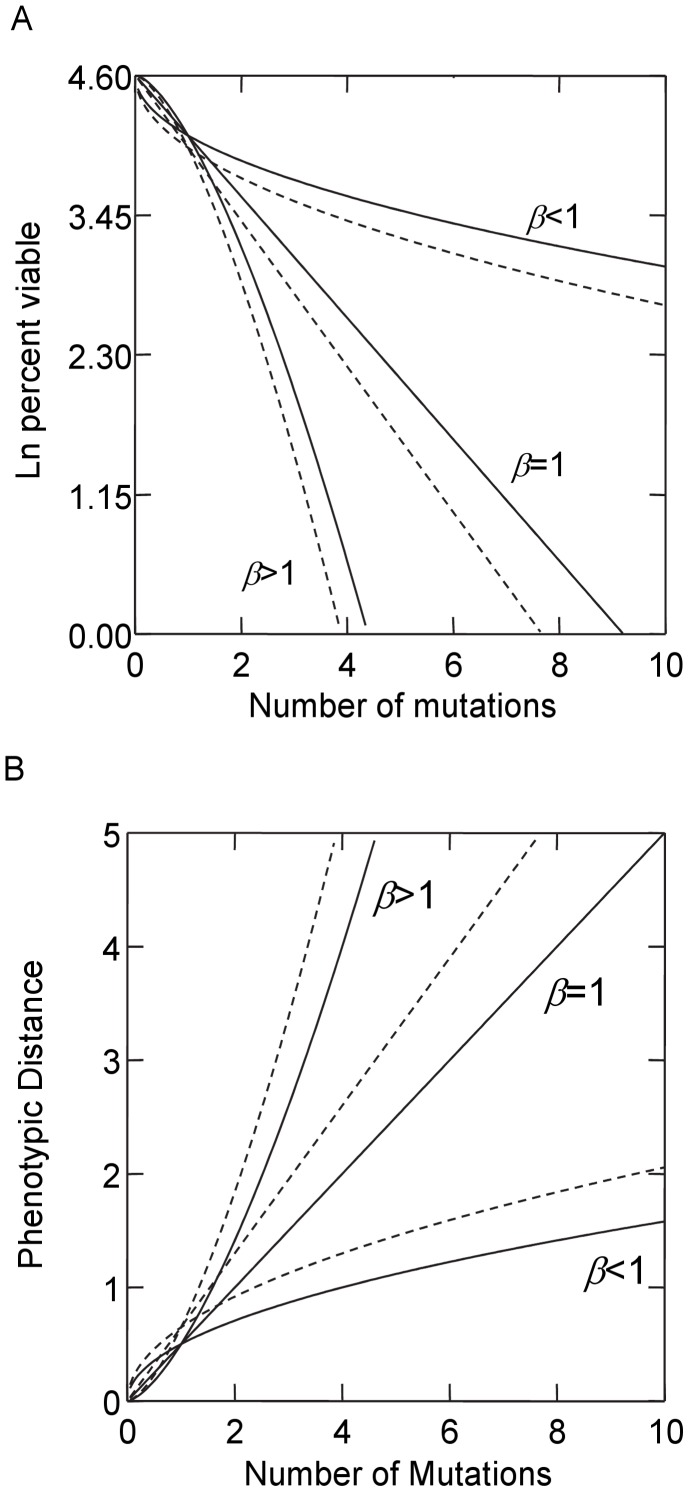
Hypothetical relationships between correlates of fitness (Wm) and number of mutations (m).(A) Effects of lethal mutations measured as the natural log of the percent of mutants that are viable (Wm); curves were generated using the relationship ln(Wm) = −αmβ+ ln(100). (B) Effects of mutations on the phenotypic distance between the mutant and wild type; curves were generated using Wm = αmβ. For both A and B, β measures the strength and direction of epistasis. β>1 indicates negative directional (or synergistic) epistasis in which each subsequent mutation has a greater effect than the last, β<1 indicates positive directional (or antagonistic) epistasis in which effects of mutations become weaker as they accumulate, and β = 1 indicates effects of mutations are the same as they accumulate. Each dashed lines corresponds to larger α and stronger effects of mutations relative to the paired solid line.